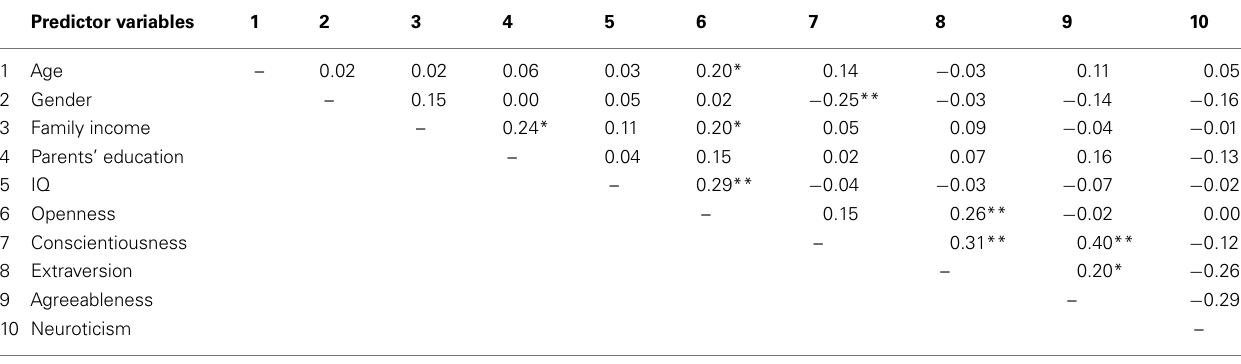
Table 1 | Correlations among predictor variables in study 1 (undergraduates). Predictor